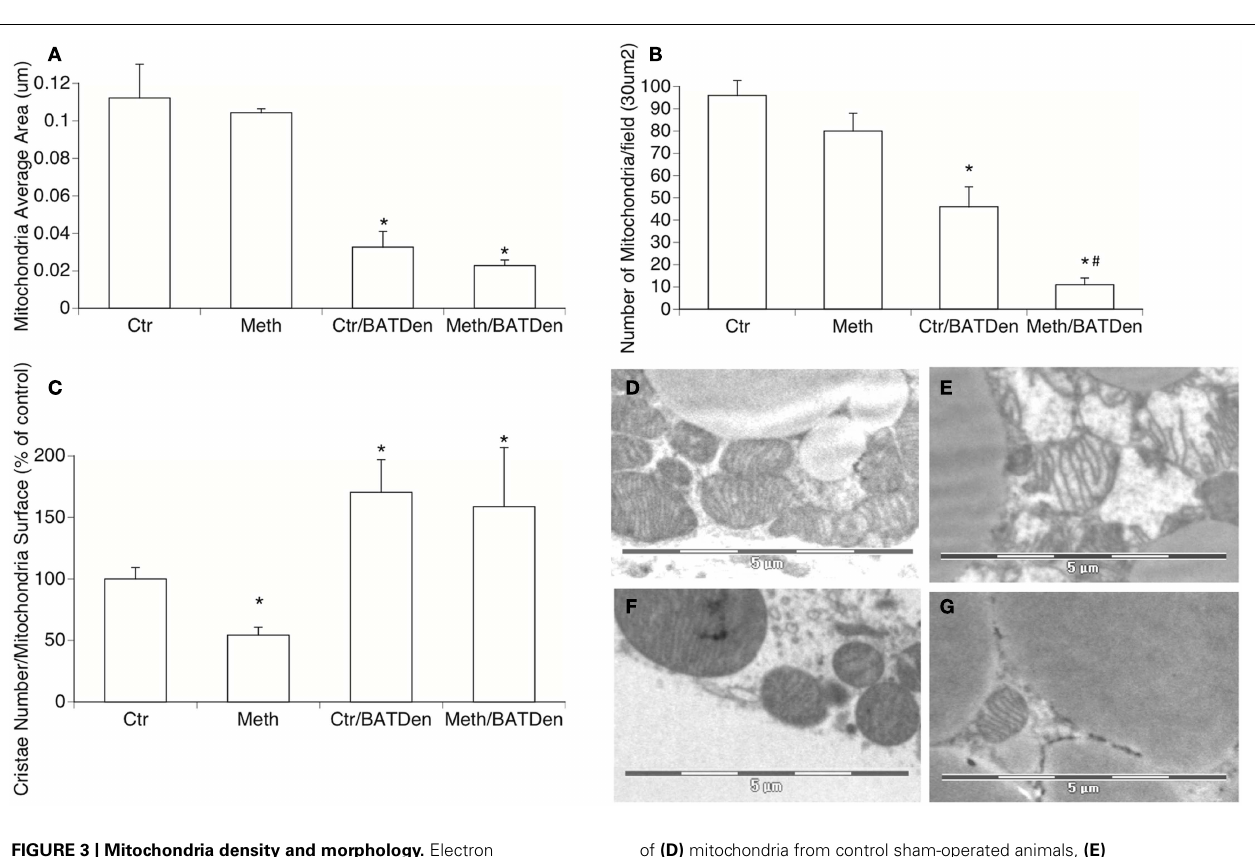
FIGURE 3 | Mitochondria density and morphology. Electron microscopy was utilized to investigate changes in density and shape of mitochondria in BAT due to Meth, under sympathetic regulation. The evaluation of mitochondria area (A) , number (B) , and cristae density (C) were performed on captures of BAT tissue at 3400 × magnification, using Image J 1.43u software. Representative picture